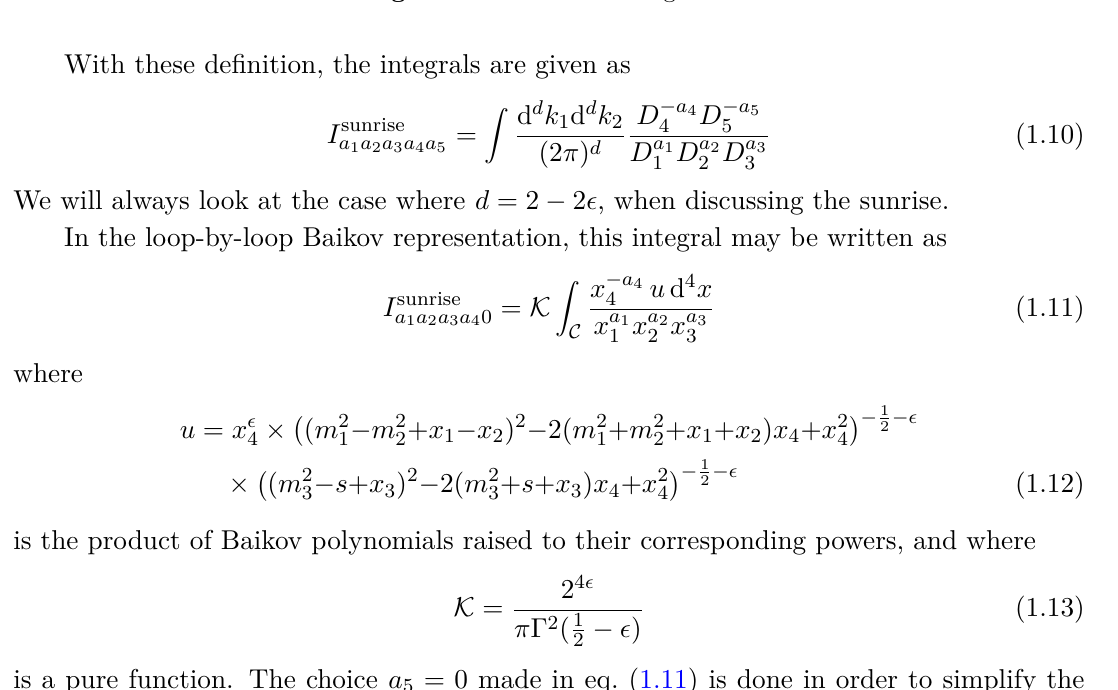
Figure 1 . The sunrise